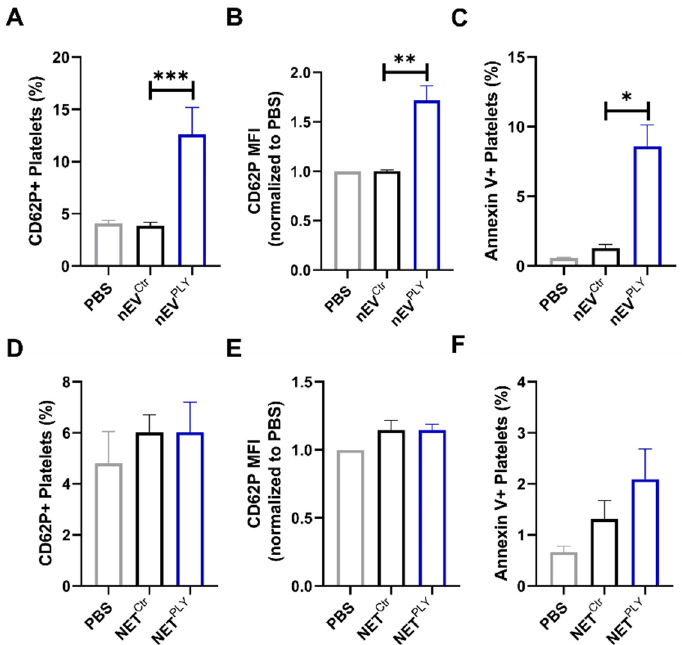
Figure 6. Effects of neutrophil extracellular traps (NETs) and vesicles (nEVs) on platelets. Human platelets were stimulated with nEVs (A–C) or NETs (D–F) from control or PLY-stimulated neutrophils, and CD62P/annexin V expression was assessed by flow cytometry. ( A ) Percentage of CD62P positive platelets, ( B ) median fluorescence intensity (MFI) of CD62P in platelets, and ( C ) percentage of annexin V positive platelets treated with nEVs (derived from Ctr- or PLY-treated neutrophils; nEV Ctr , nEV PLY ). ( D ) Percentage of CD62P positive platelets, ( E ) MFI of CD62P in platelets, and ( F ) percentage of annexin V positive platelets treated with NETs (from Ctr- or PLY-treated neutrophils; NET Ctr , NET PLY ). n = 5–10. * p < 0.05, ** p < 0.01, *** p < 0.001, Kruskal–Wallis test.